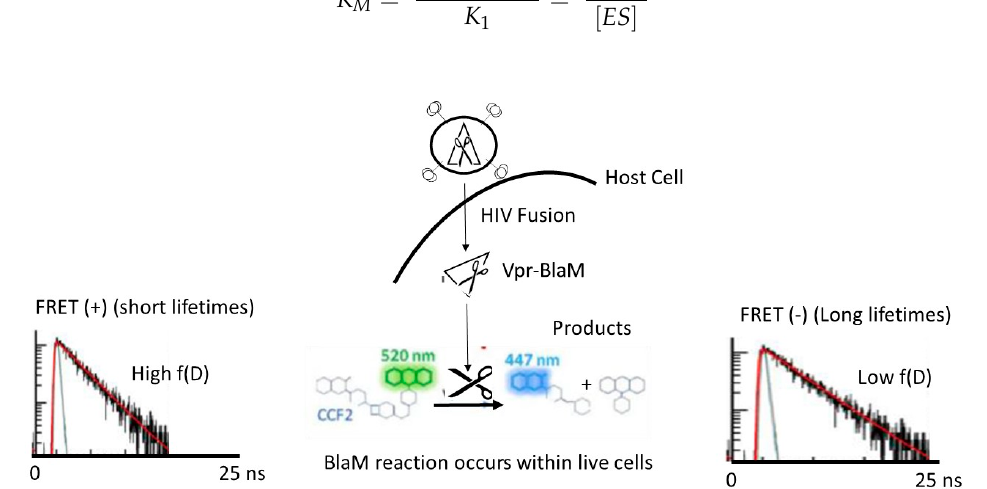
Figure 1. Schema of the β -lactamase (BlaM) assay applied to study human immunodeficiency virus type 1 (HIV-1) fusion utilizing intensity-based Förster resonance energy transfer (FRET) approaches and FRET fluorescence lifetime imaging microscopy (FLIM). HIV-1 pseudoparticles bearing the Vpr-BlaM are exposed to live cells expressing CD4 and co-receptors so that the HIV-1 particles are allowed to fuse with the host membrane and release their capsid into the host cytosol. The BlaM enzyme reaches the CCF2-AM FRET biosensor composed of hydroxycoumarin linked to fluorescein by the BlaM recognition domain. Once the BlaM enzyme starts the catalytic reaction, CCF2-AM is cleaved into hydroxycoumarin (donor) and fluorescein (acceptor) and FRET is disrupted. When employing FLIM, one can apply a two-exponential method that takes into account the situation in which not all fluorophore is engaged in FRET. A change from green to blue is also observed when looking at the visible emission spectra of CCF2-AM during the BlaM enzymatic reaction. The green emission (~520 nm) when exciting hydroxycoumarin at 405 nm comes from FRET; when CCF2-AM is cleaved hydroxycoumarin emits in the blue (~447